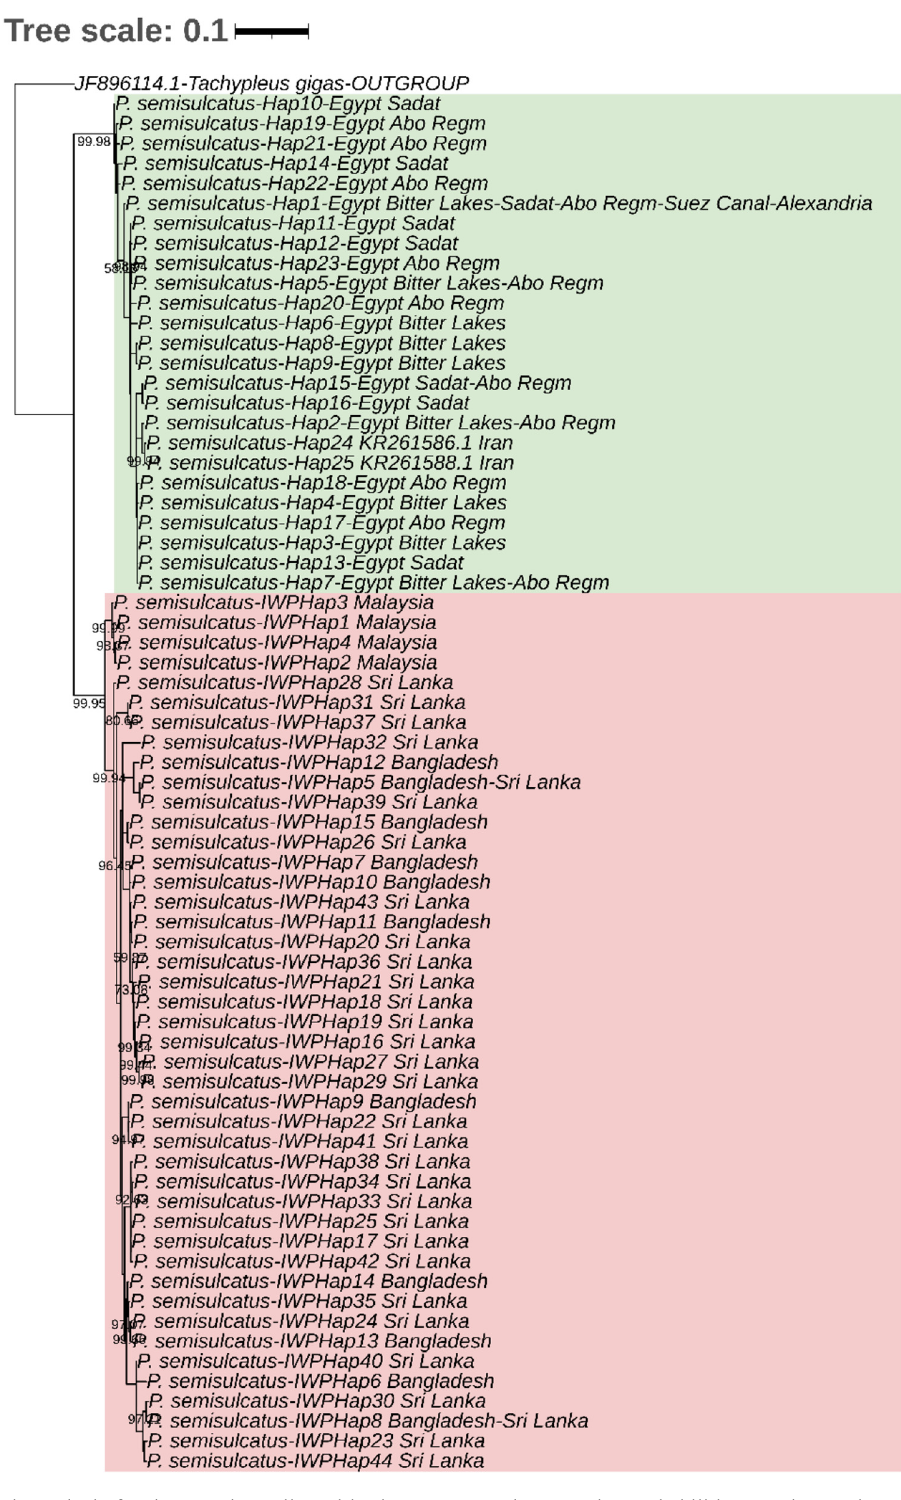
Fig. 6. BI phylogenetic analysis for the samples collected in the present study. Posterior probabilities are shown above the branches. Green highlighted: Gulf of Suez P. semisulcatus haplotypes (Hap), and the closely related ones form the Arabian Gulf and the Mediterranean Sea. Red- highlighted: Indo-West Paci fi c (IWP) haplotypes. Tree outgroup: the Southern Horseshoe crab Tachypleus gigas .